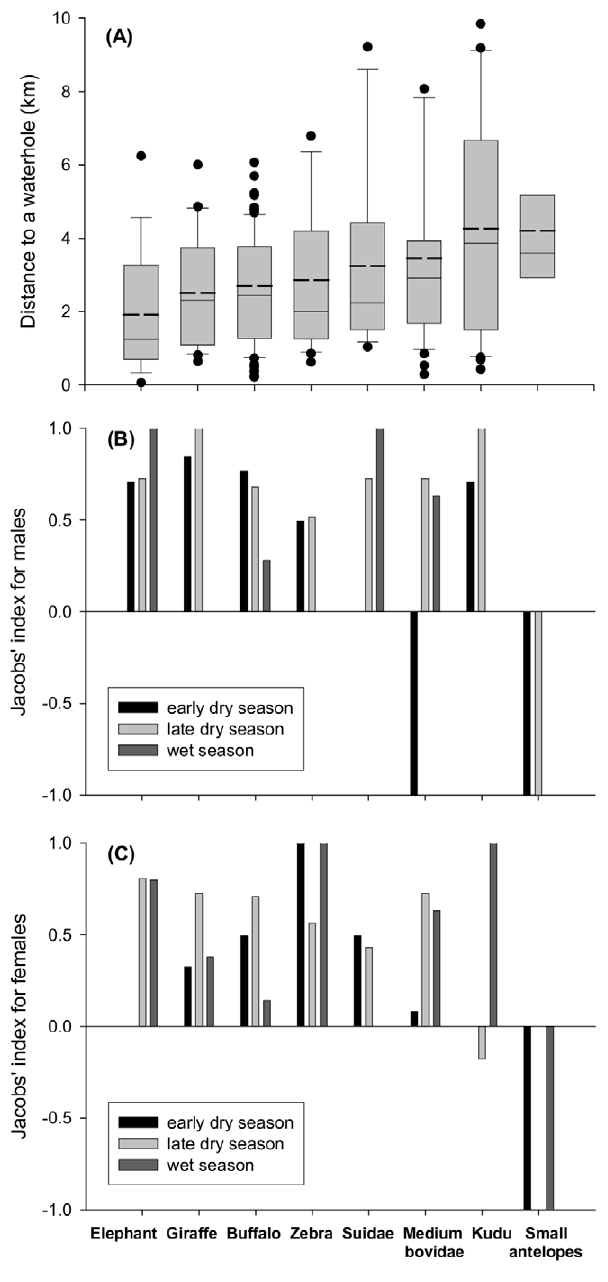
Figure 3. (A) Mean distance to a waterhole for kills for the different prey species. Boxes show medians, 25% and 75% quartiles. Bold dashed lines indicate means. Whiskers indicate the range between 10% and 90% percentiles. Dots represent data outside this range. (B) and (C) Jacobs’ index of seasonal preference to kill within 2 km of a waterhole for the different prey species for male and female lions respectively. Values . 0 indicate preference, values , 0 suggest use but